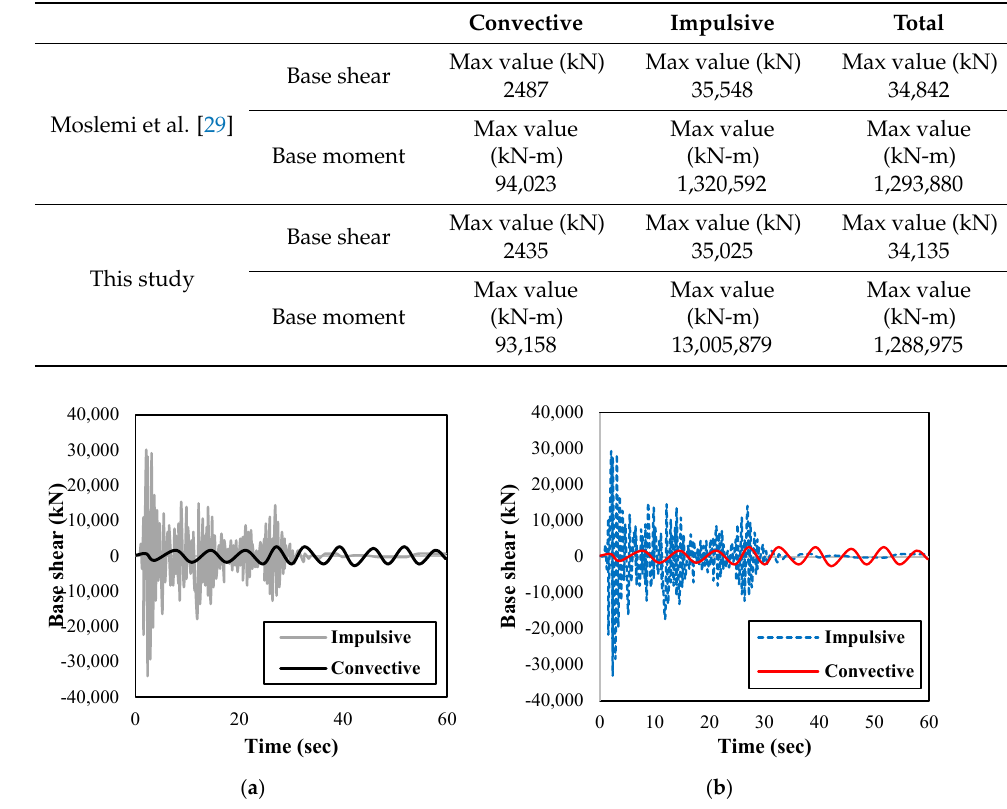
Table 1. Maximum absolute time history response values for the elevated tank model.